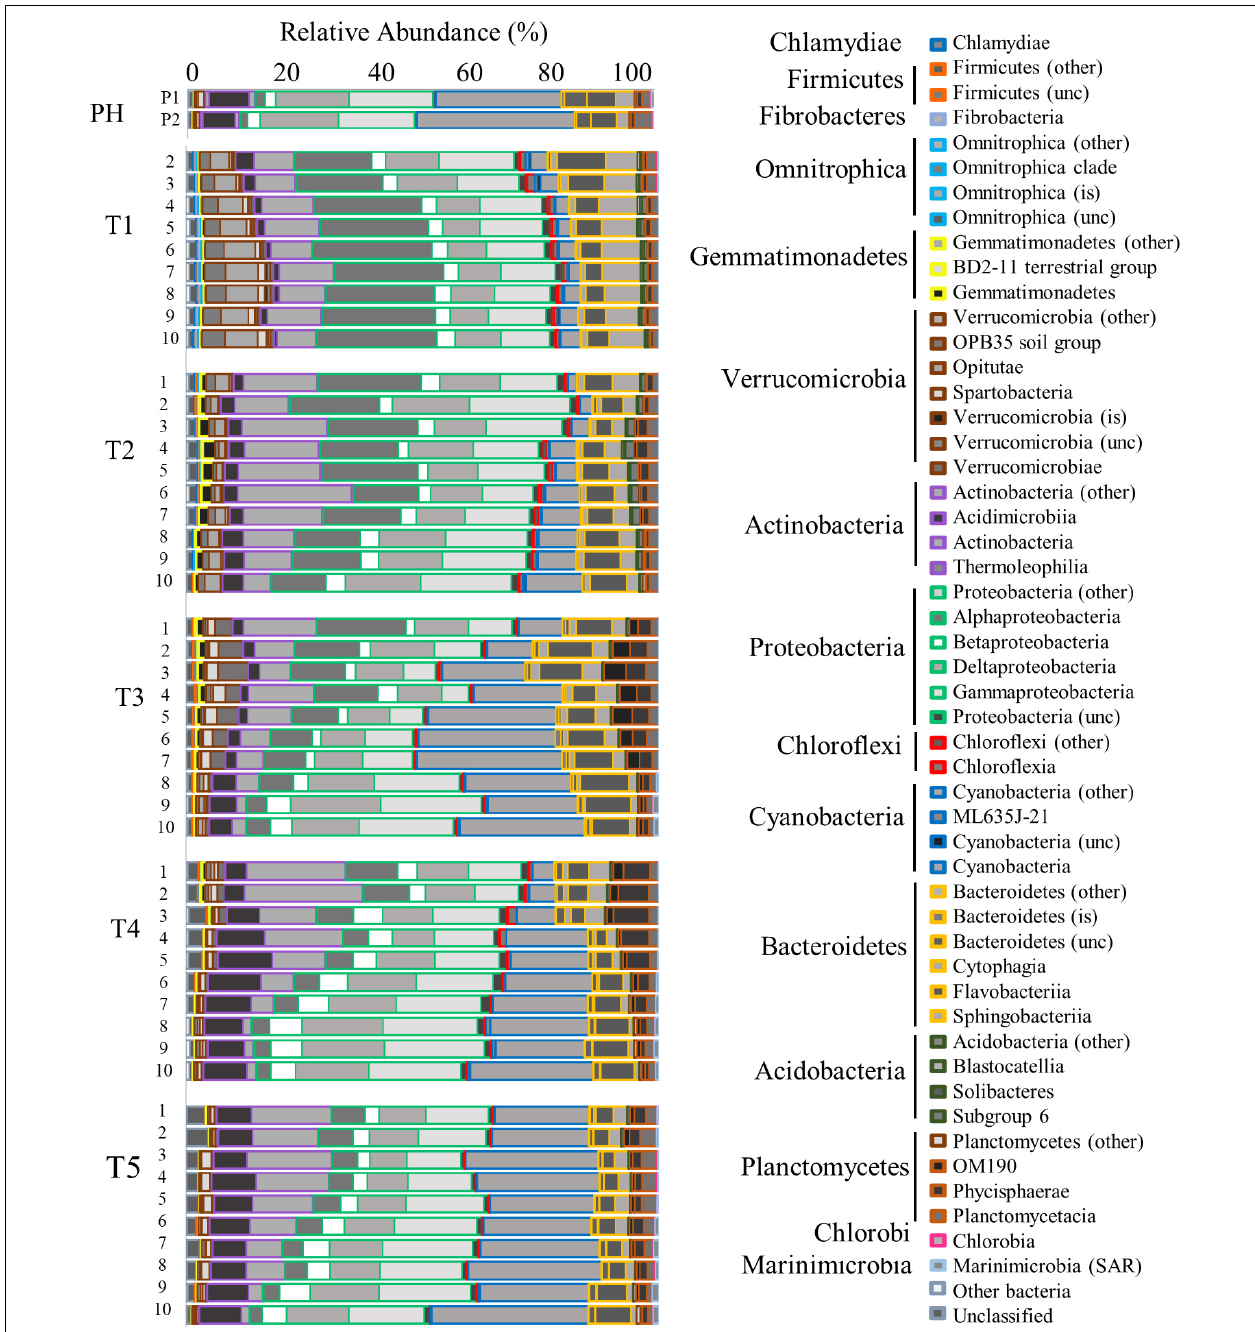
FIGURE 5 | Bar graph showing the relative abundance of OTUs for the Bacteria community identified by 16s rRNA analysis. Time points are separated into blocks (T1–T5). Within each time point block, each bar represents the relative abundance for the members of the Bacteria community at each station (1–10). The phyla are indicated by differing border color on the bar graphs [incertae sedis (is) and unclassified (unc)]. P1 and P2 are pre-Harvey (PH) samples from 07/31/17 and 08/22/17, respectively.